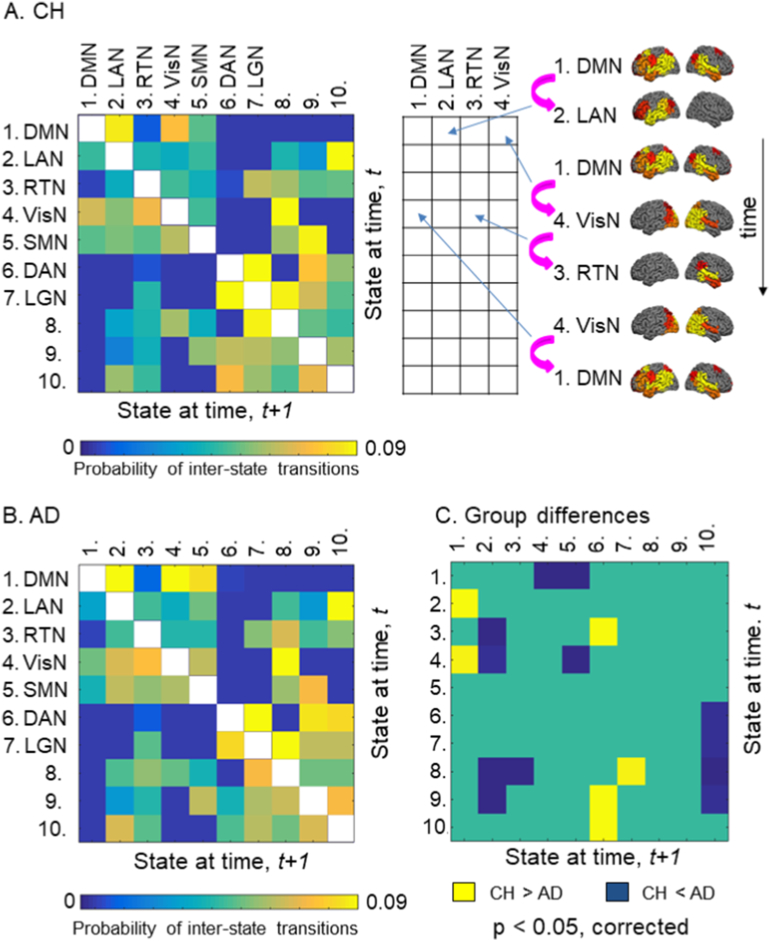
State-to-state transitions. A. Transition probability matrix for the CH group. Shown is the probability of transitioning from a certain state (labeled in rows) at the time-point, t, to any other state (labeled in columns) at the time-point, t + 1. The correspondence between state-to-state transitions and the loci in the matrix is illustrated on the right. The transitions in a sample sequence of HMM states, indicated by magenta arrows, would be recorded within the first four columns of the matrix, as indicated by blue arrows. B. Transition probability matrix for the AD group. C. Group differences; the lower and higher transition probabilities in the AD group relative to CH group are represented by yellow and blue colors, respectively.